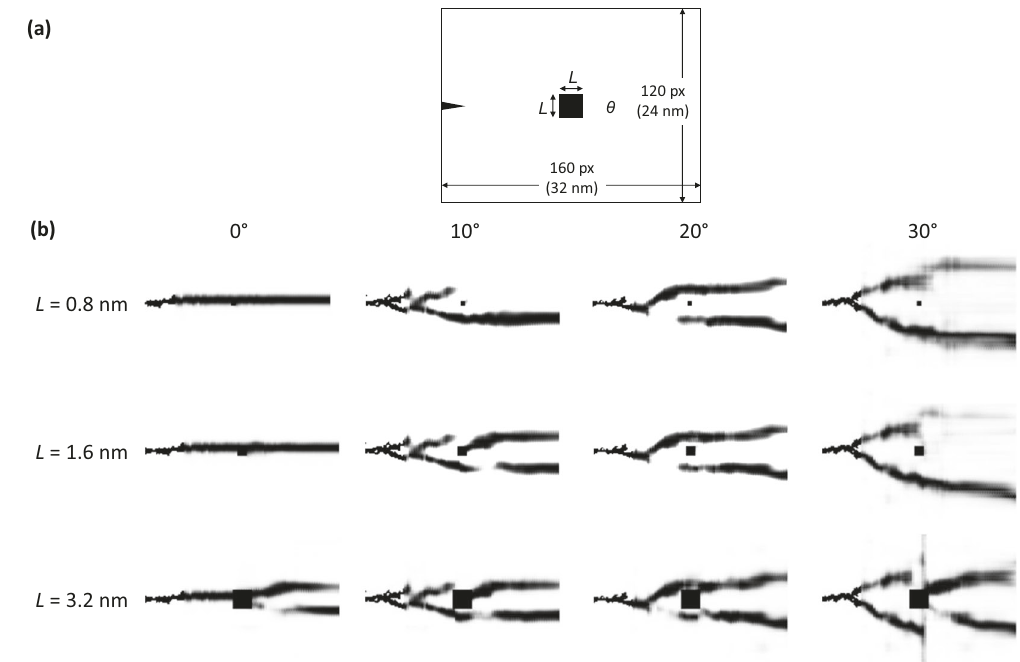
Fig. 5 Prediction of fl aw tolerance. ML predictions show a degree of fl aw tolerance, assessing fracture mechanics due to a pre-existing crack. The ML model predicts fracture paths given a 160 × 120 pixel images populated with values θ , representing sheets of graphene 32 × 24 nm with orientation angle θ . To introduce hole defects to the sample, a square region in the center of the image of size L × L is pre-labeled as “ cracked ” with the value − 1 prior to starting fracture predictions. As the images show, b small hole defects placed in the center of graphene sheets only slightly affect the predicted fracture paths from the pristine samples. However, as fl aw size increases to 3.2 nm, signi fi cant deviation occurs in the form of additional crack branching. This change in behavior at 3.2 nm is consistent with the threshold reported in the literature 29 for nanocrystalline graphene fl aw tolerance — and may be the mechanism by which fracture strength is reportedly unaffected by fl aw sizes below 3.2 nm but decreased with larger fl aw